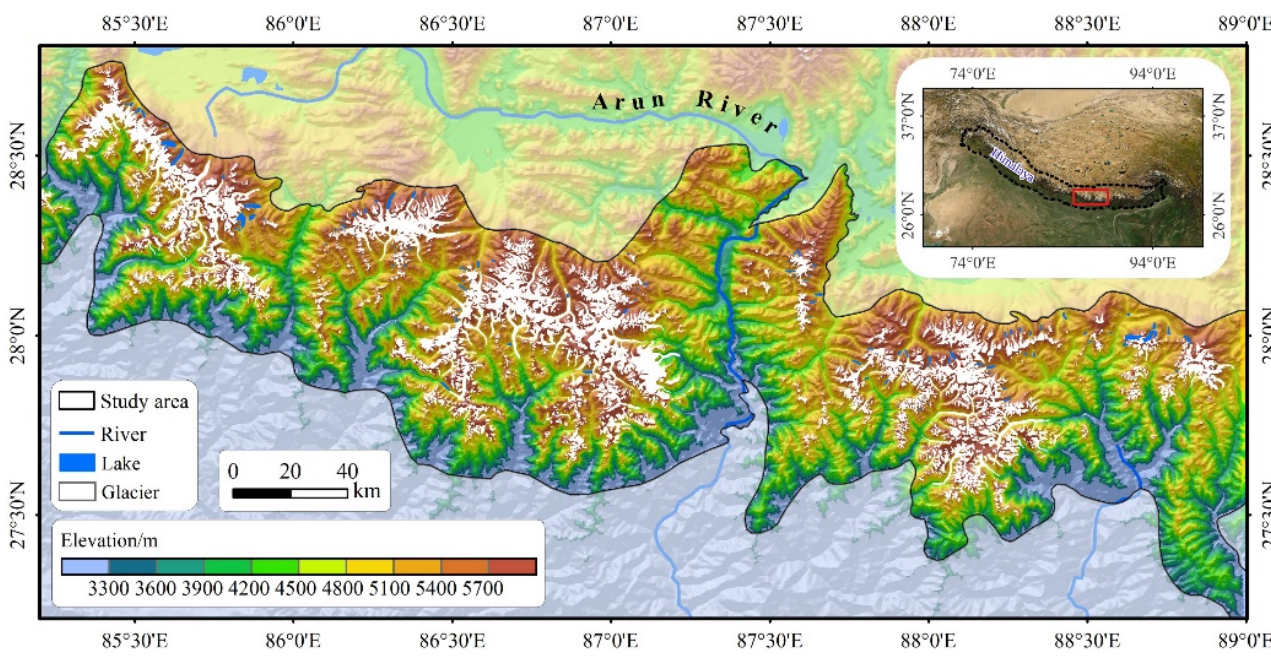
Figure 1. Study area in the Eastern Himalayas (85.2–89° E).